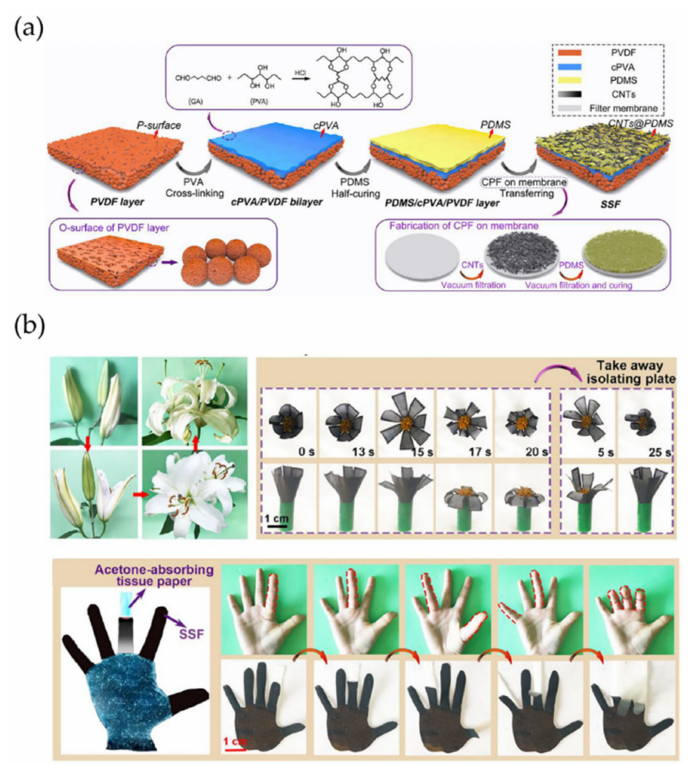
Figure 23. ( a ) Schematic diagram indicating the fabrication of durable stimuli-responsive superhy- drophobic films (SSF). ( b ) Illustration of the flower and finger devices. Reproduced with permission from the reference. Reproduced with permission from reference [85]. Copyright 2020, Elsevier